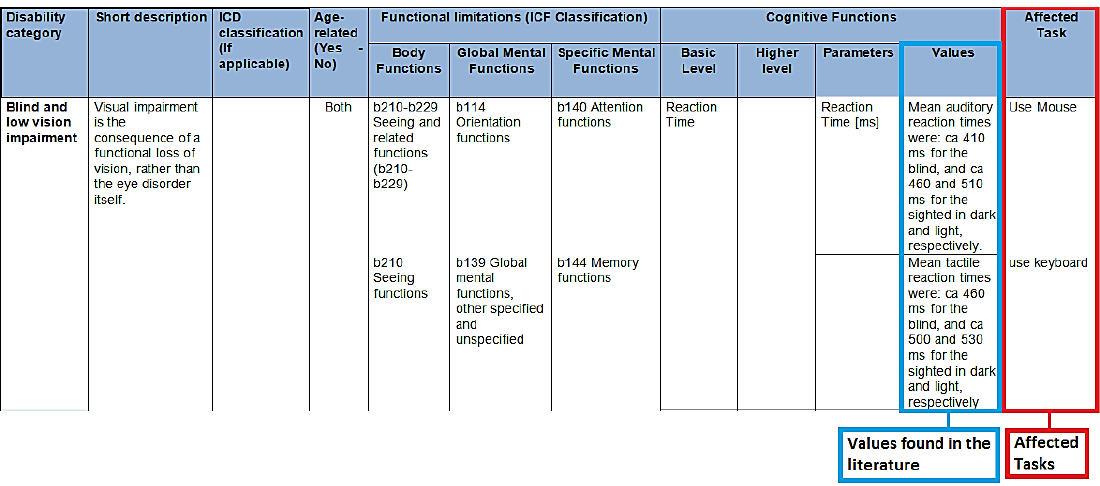
Figure 5. Cognitive AUM representation with affected tasks.